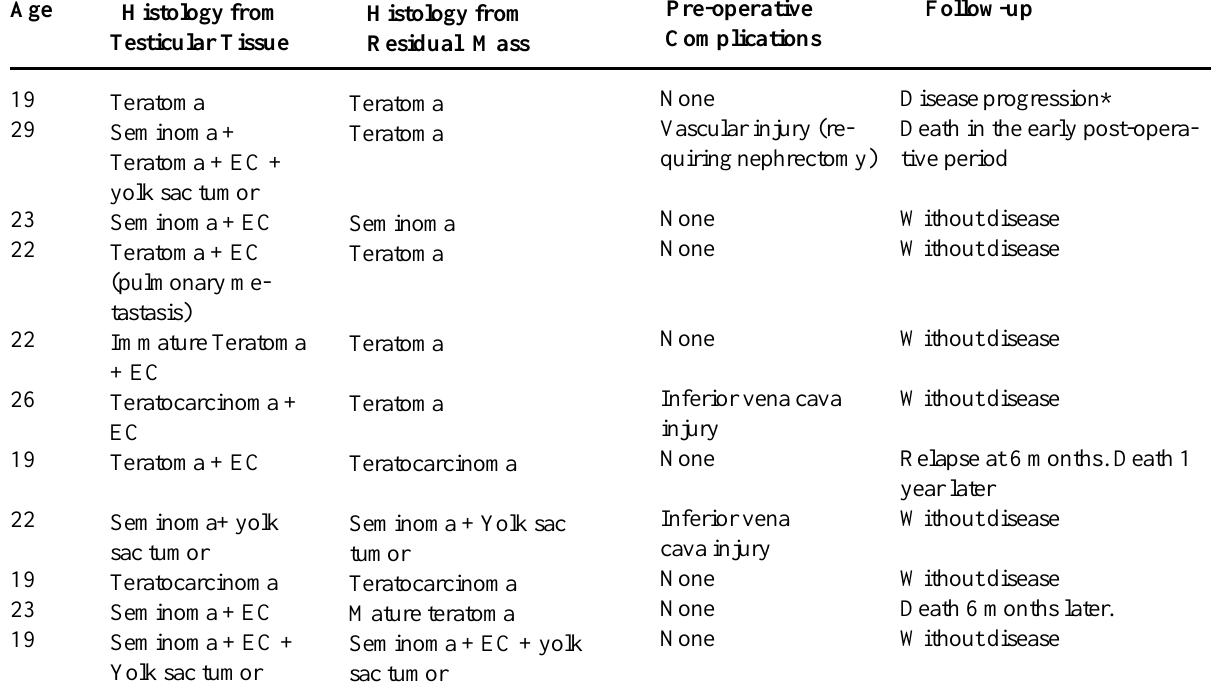
Table 1 – Patients’ features with nonseminomatous germ cell cancer undergoing salvage surgery after chemotherapy for residual